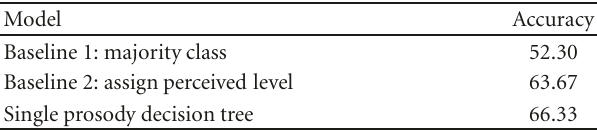
Table 2: Accuracies for classifying self-reported level of certainty for the initial prosody decision tree model and two baselines. The prosody decision tree model is better than choosing the majority class and better than assigning the level to be the same as the perceived level.